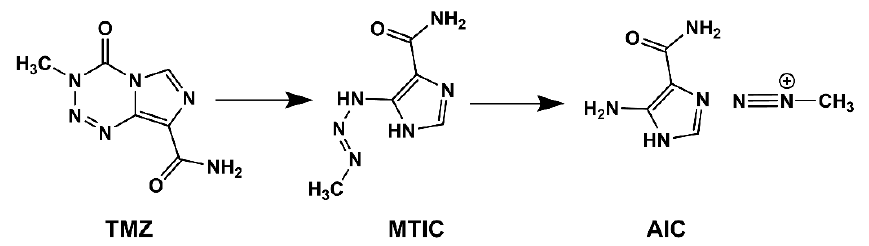
Figure 1. TMZ degradation pathway.